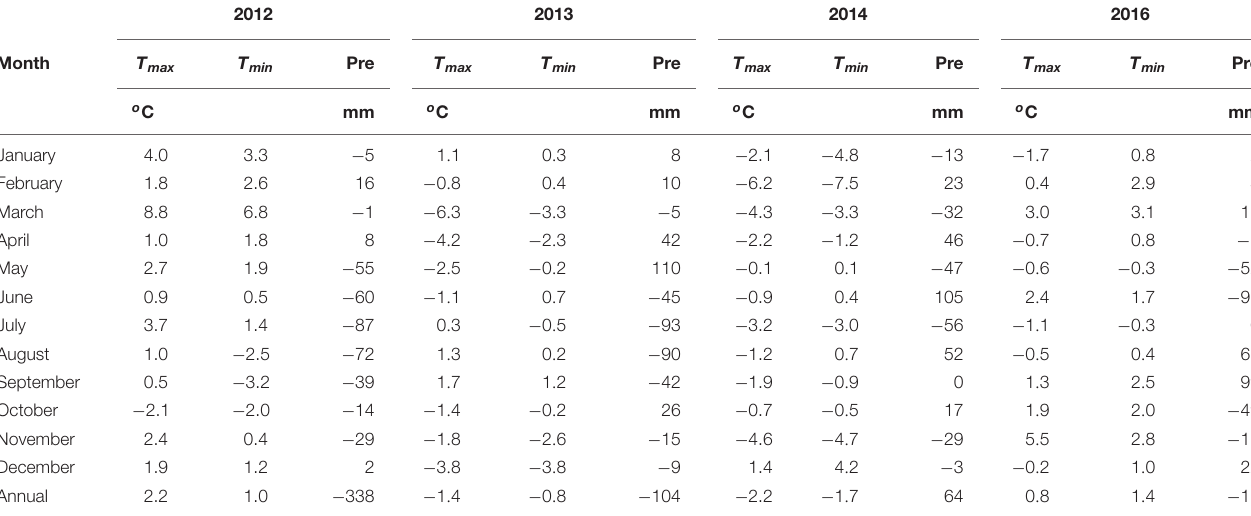
TABLE 1 | Deviations from the 30-year average (1981–2010; Ames, IA, United States) for monthly maximum ( T max ) and minimum ( T min ) temperature and precipitation (Pre) for the 4 years of the study and its two field sites near Ames and Kelley, Story County, IA, United